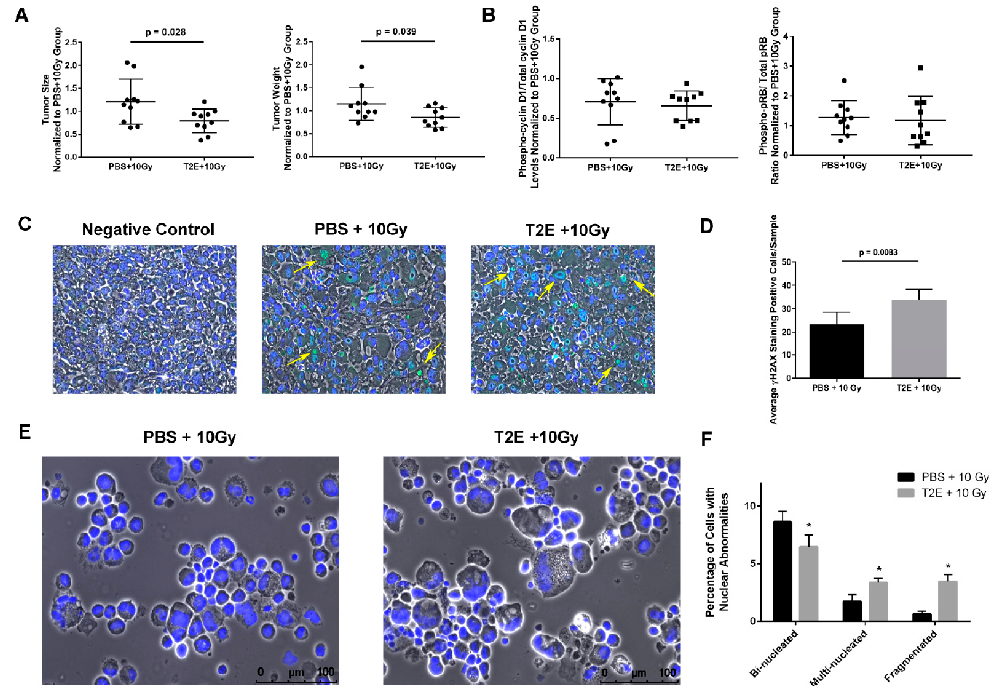
Figure 8. E ff ects of MnTE-2-PyP with radiation in PC3 tumors in vivo. ( A ) Left panel: In vivo PC3 tumor size; right panel: In vivo PC3 tumor weight after PBS or MnTE-2-PyP + 5 days x 2Gy / day treatment. ( B ) Left panel: phosphorylation level of cyclin D1 in PC3 tumor samples; right panel: phosphorylation level of pRB in PC3 tumor samples. ( C ) Representative images of γ H2AX positive cells in each condition. Each arrow indicates a single cell with γ H2AX positive staining, part of the positive cells were shown. ( D ) Quantification of γ H2AX-positive cells in PC3 tumor sections. Each quantified image had a similar cell density. ( E ) Representative images of nuclear abnormalities in PC3 tumor samples with PBS or MnTE-2-PyP + 10 Gy radiation treatment. ( F ) Quantification of ( E ), around 1000 cells isolated from each animal’s tumor were included in the analysis. For animal experiments, n = 10 for both PBS + 10 Gy and MnTE-2-PyP + 10 Gy. * p < 0.05 compared to PBS + 10 Gy treatment.